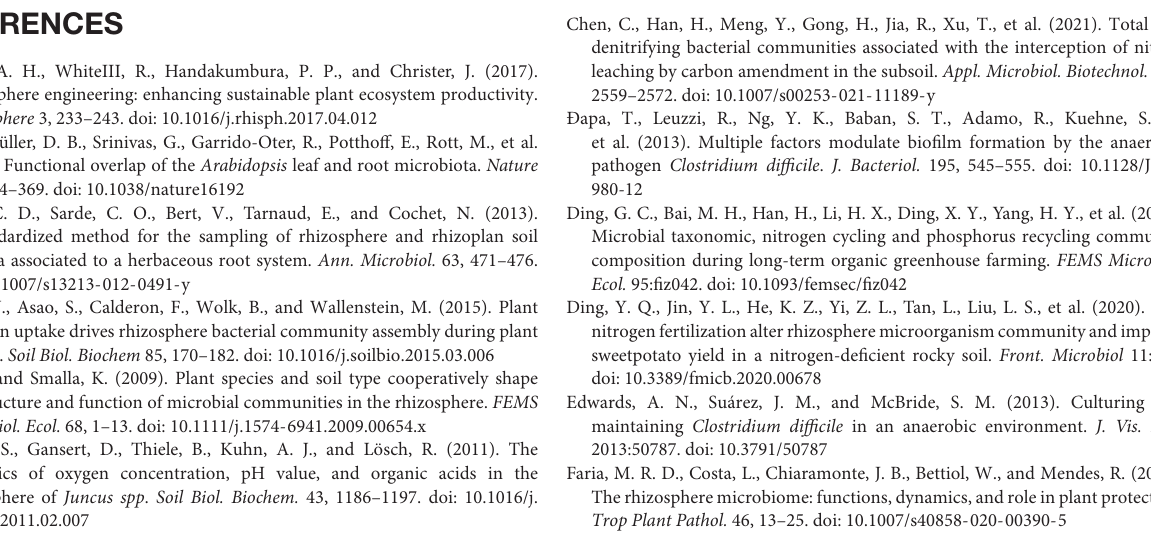
Supplementary Figure 1 | Average relative abundance of reads mapped against all in vitro antagonists. Significant differences ( p < 0.05, multiple comparisons under negative binomial model) are indicated by different